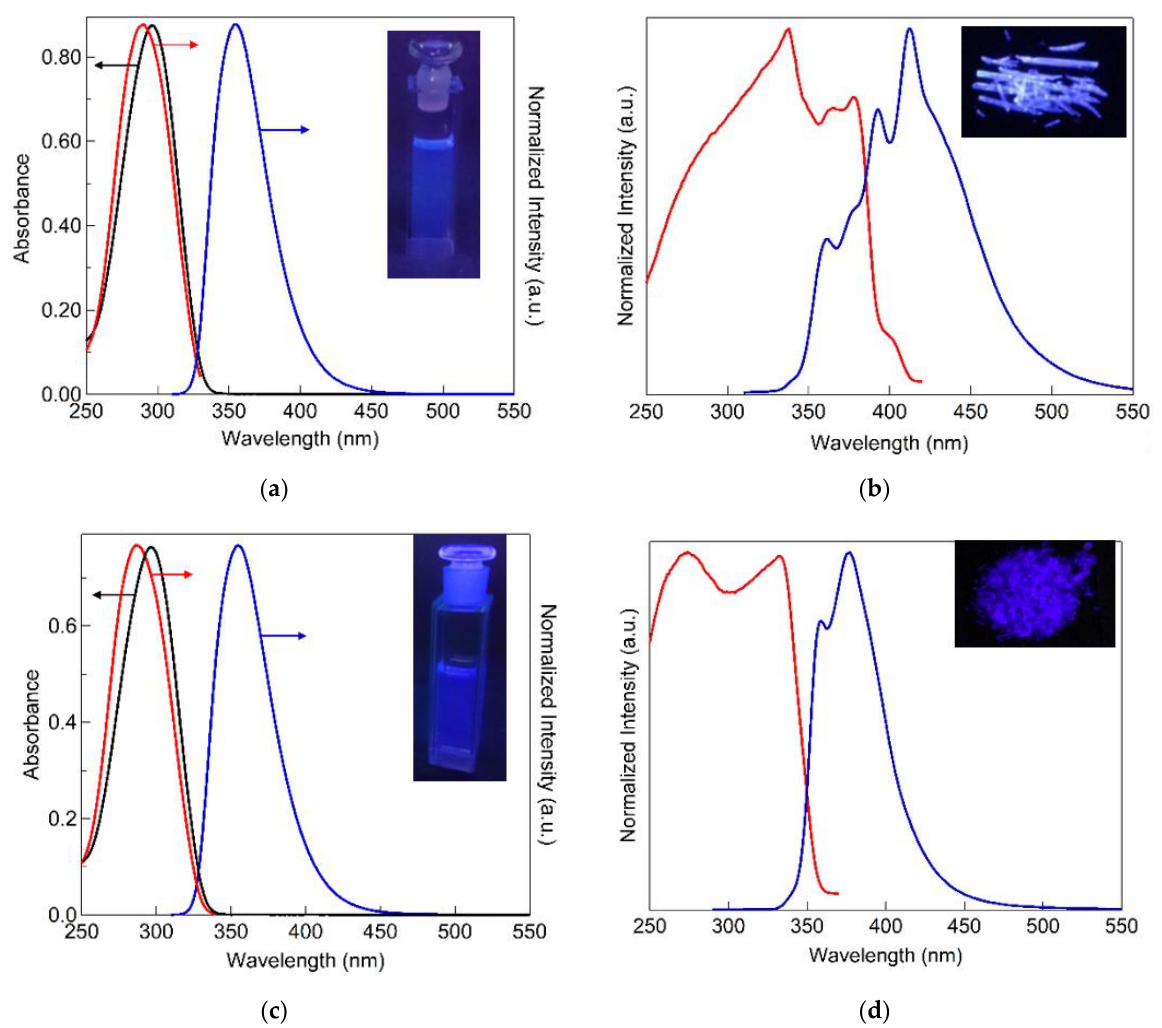
Figure 6. Photophysical properties of biphenylacetylene compounds. Absorption (black, 2.0 × 10 − 5 mol L − 1 ), corrected photoluminescence (blue, 2.0 × 10 − 6 mol L − 1 , λ ex = 313 nm), and excitation (red, λ em = 355 nm, 2.0 × 10 − 6 mol L − 1 ) spectra of ( a ) 5-BPTMS and ( c ) 6-BPTMS in CH 2 Cl 2 solution. Excitation (red) and corrected photoluminescence (blue) spectra of ( b ) 5-BPTMS and ( d ) 6-BPTMS in crystals. Insets: corresponding photographs of the solutions and crystals under UV irradiation at 365